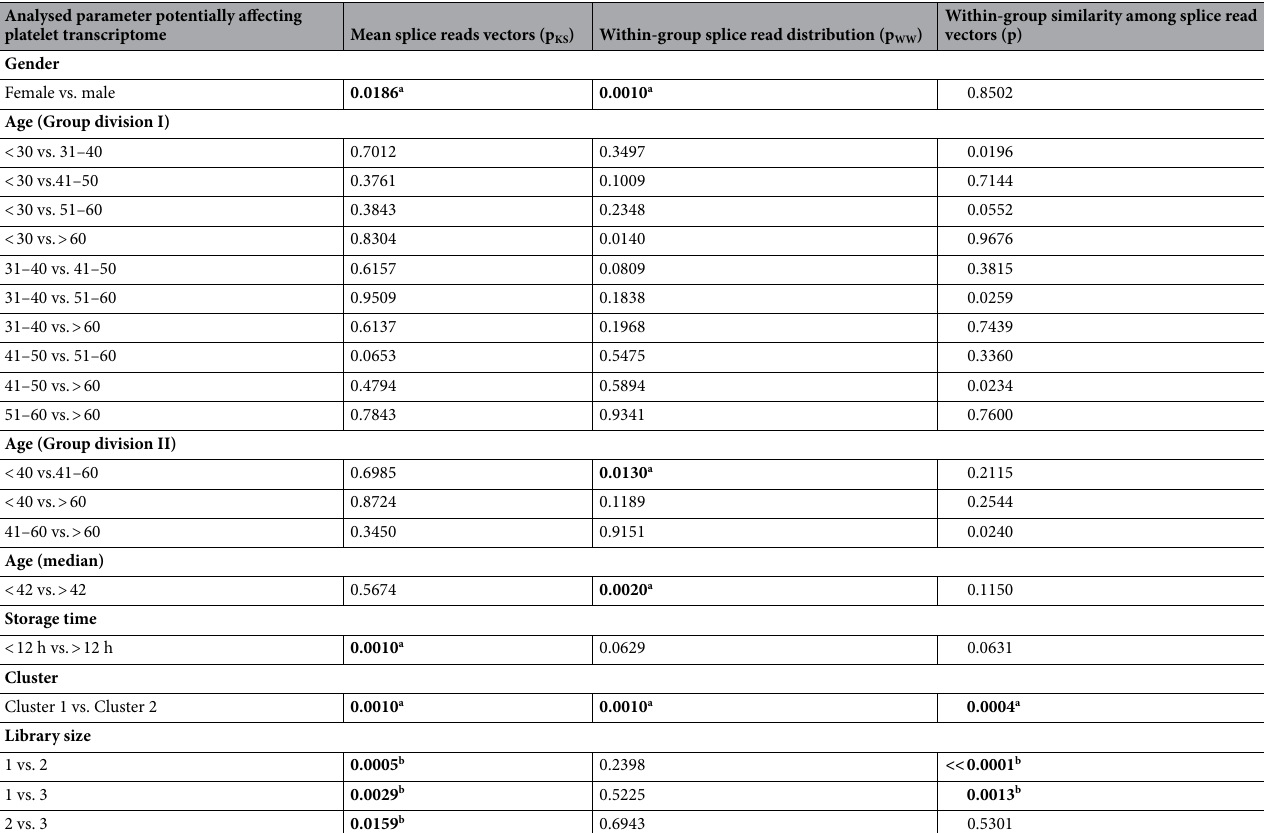
Table 1. Summary of analysis of variability associated with selected factors. Values below the assumed thresholds are marked in bold. a p threshold = 0.0500. b p threshold =